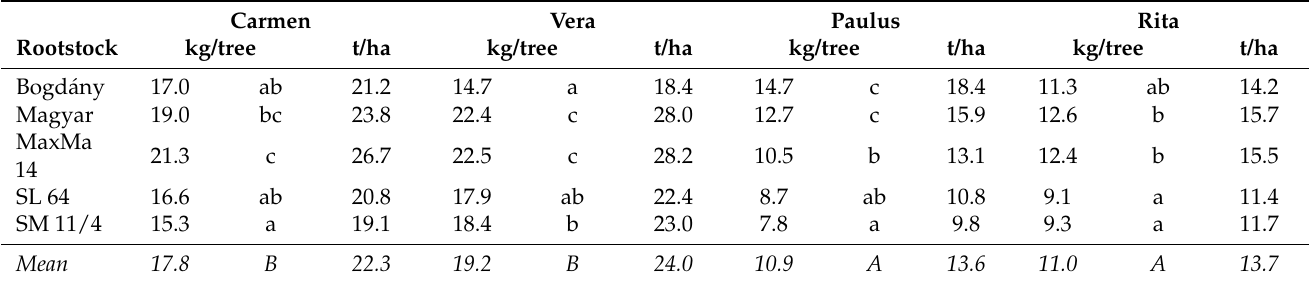
Table 6. Calculated cropping capacity of trees in 2022 (full crop